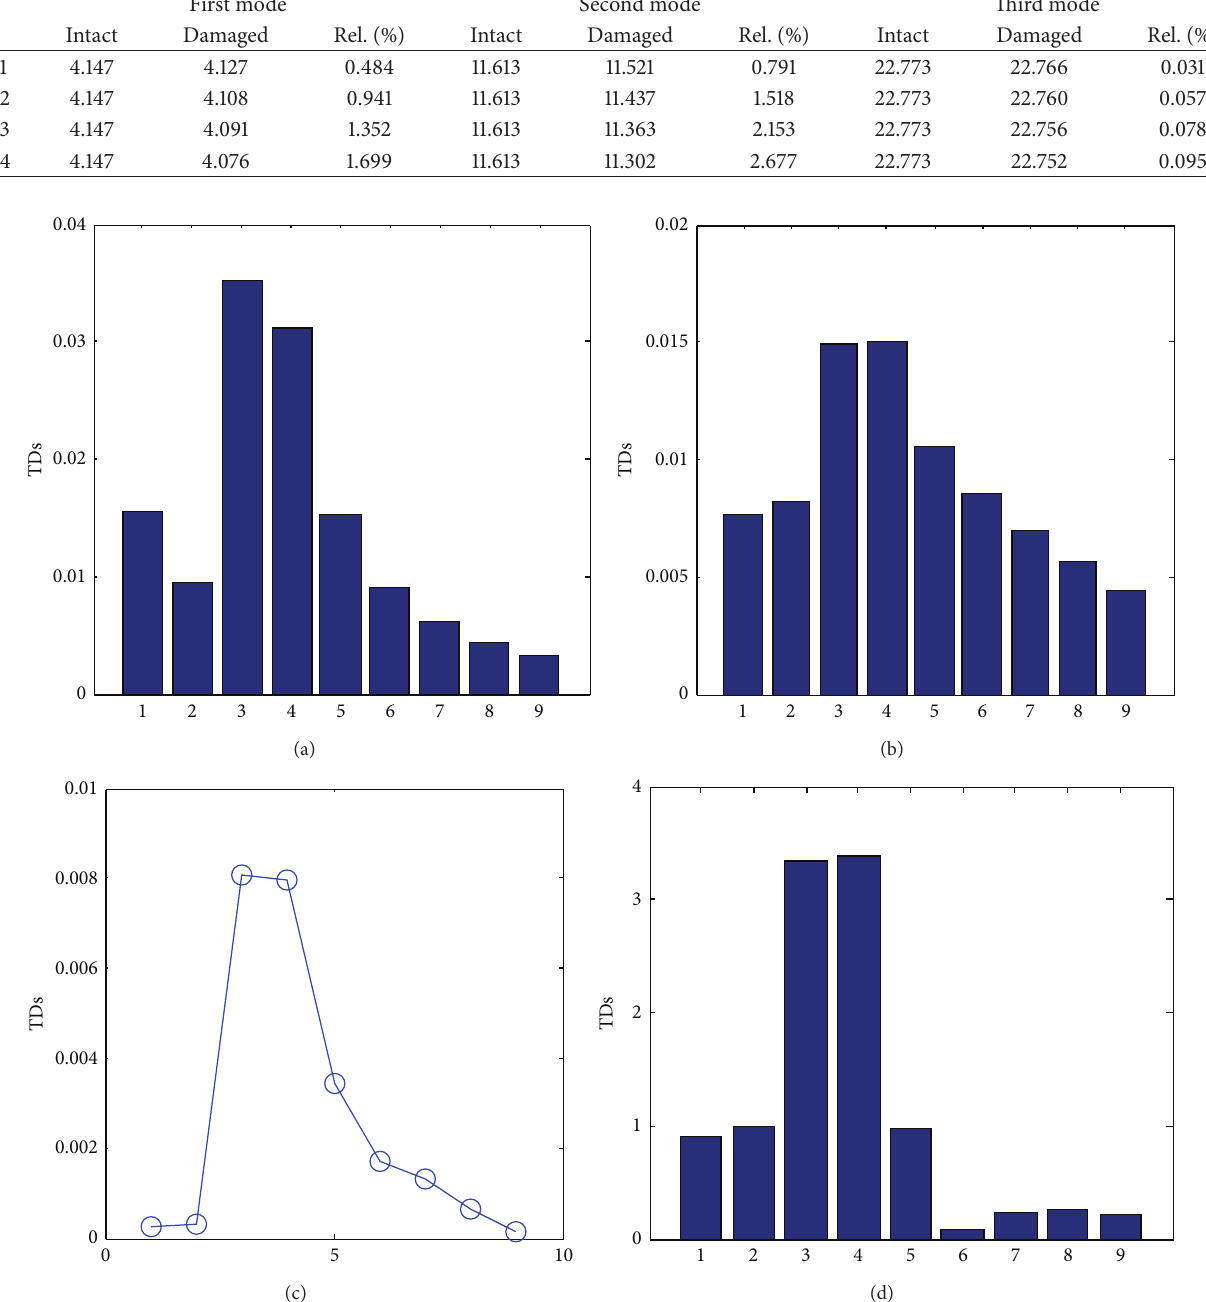
Table 2: Comparison of natural frequencies of intact and damaged cantilever beam with different crack depth ratios. 𝛾 First mode